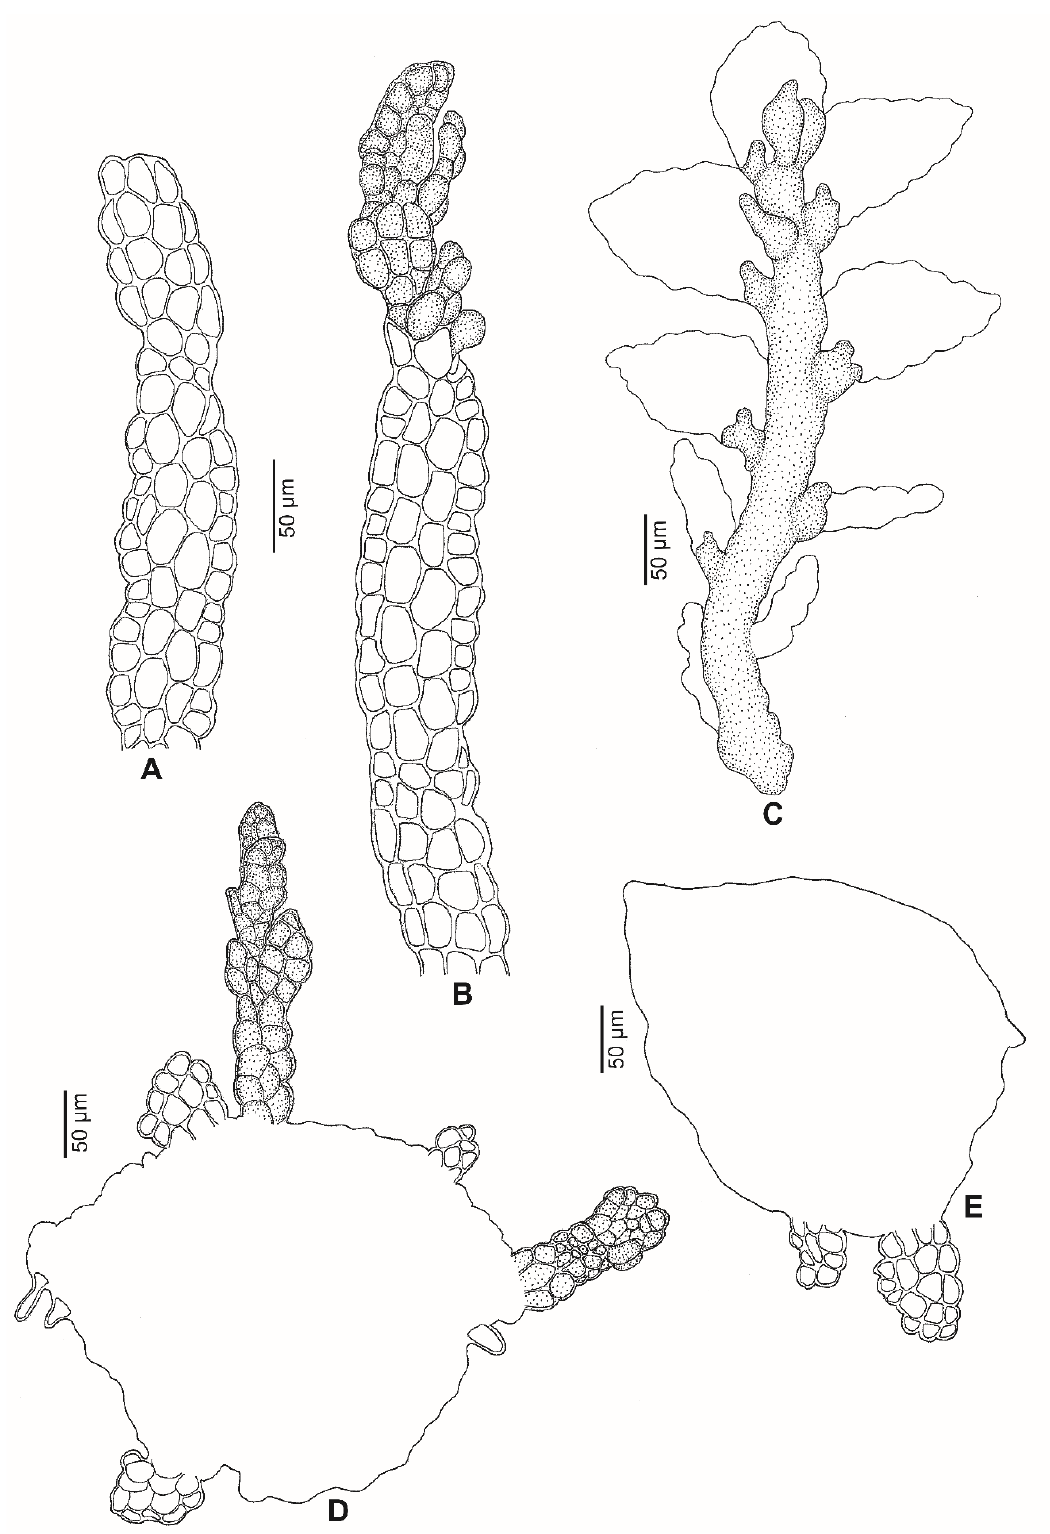
Figure 4. Vegetative reproduction of Lejeunea malaysiana G.E. Lee and Pócs, sp. nov . ( A ) Ribbon-like regenerant. ( B ) Young plantlet on top of the ribbon-like regenerant. ( C ) Mature plantlet, fall off from the caducous leaf. ( D , E) Ribbon-like and young plantlets on marginal cells of caducous leaves. All were drawn from the holotype , G.E. Lee and H.Y. Tang 11001 (UMTP).